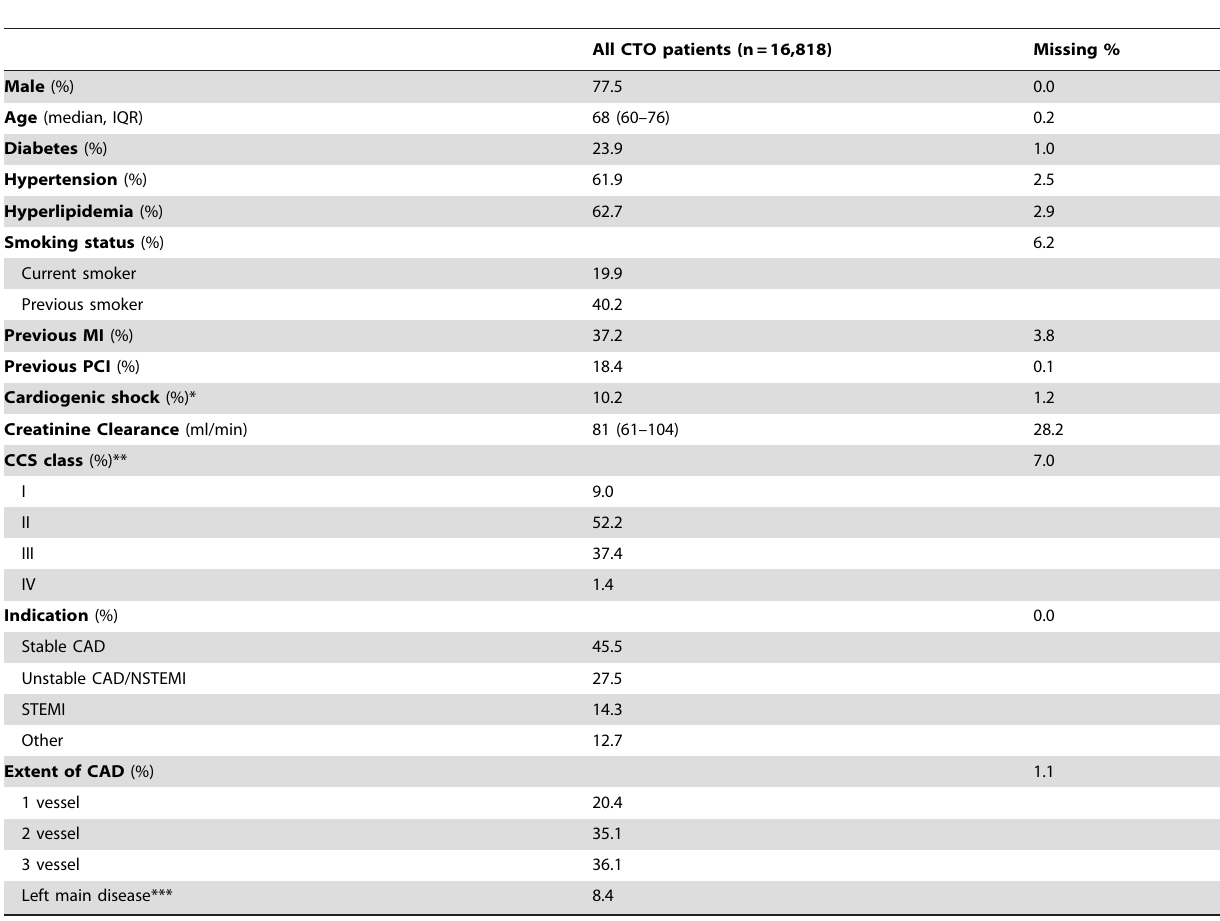
Table 1. Baseline characteristics of the total CTO cohort in SCAAR at the time of diagnosis based on data collected during the period